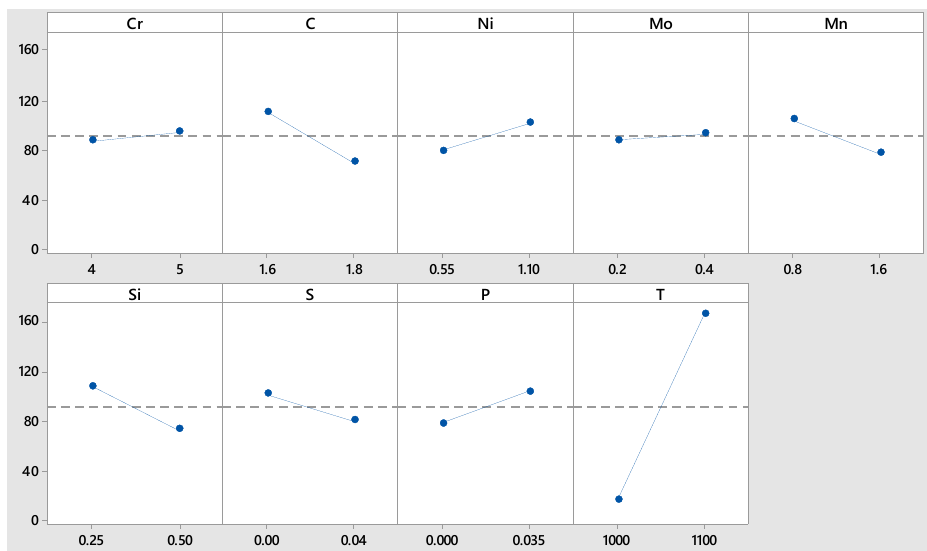
Figure 8. M 7 C 3 precipitates’ size in nanometers for the DOE Thermocalc simulation. Main average effects.